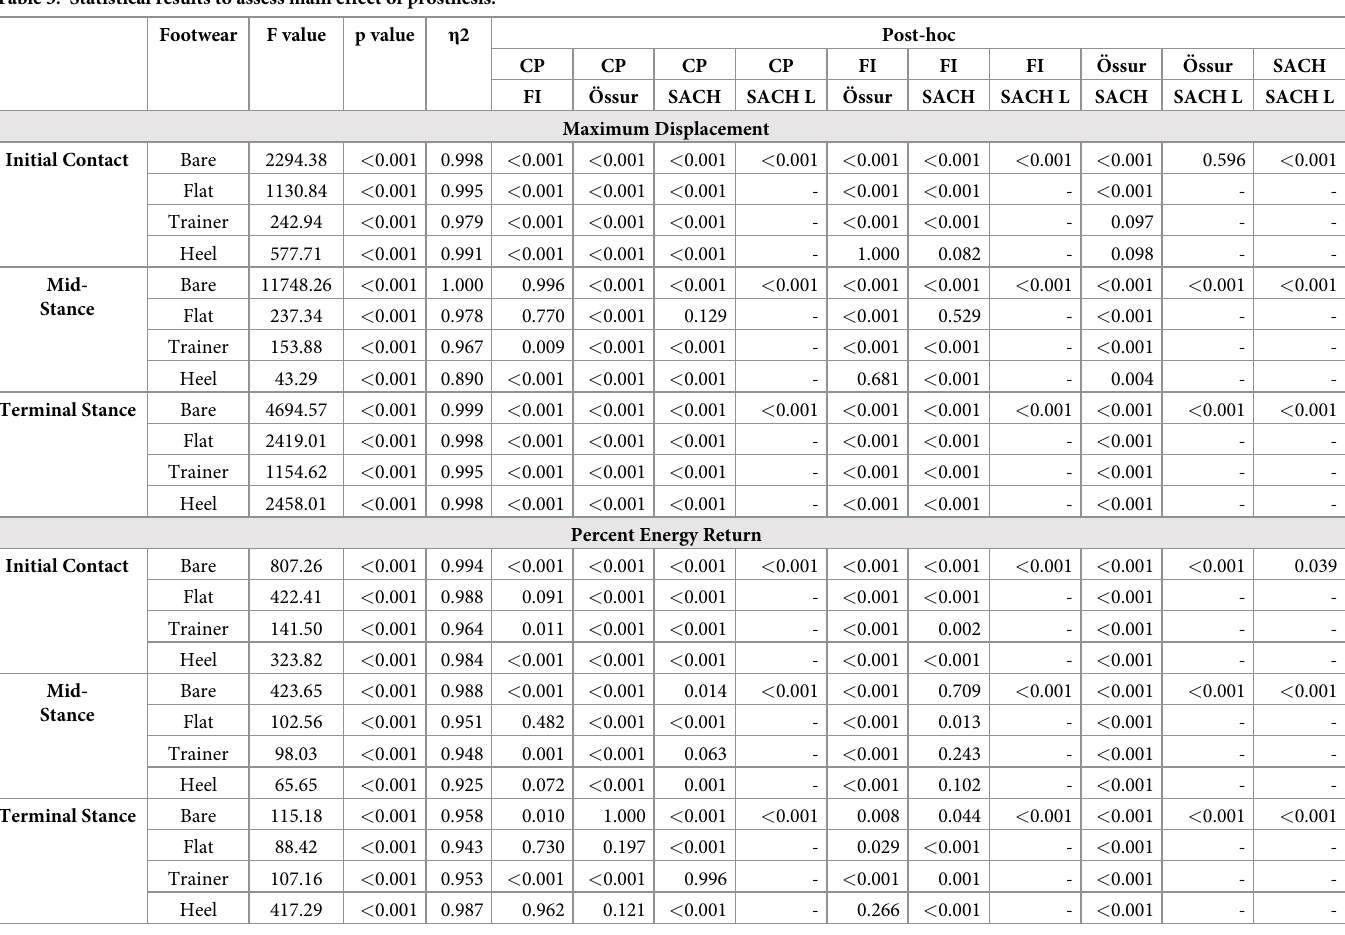
Table 5. Statistical results to assess main effect of